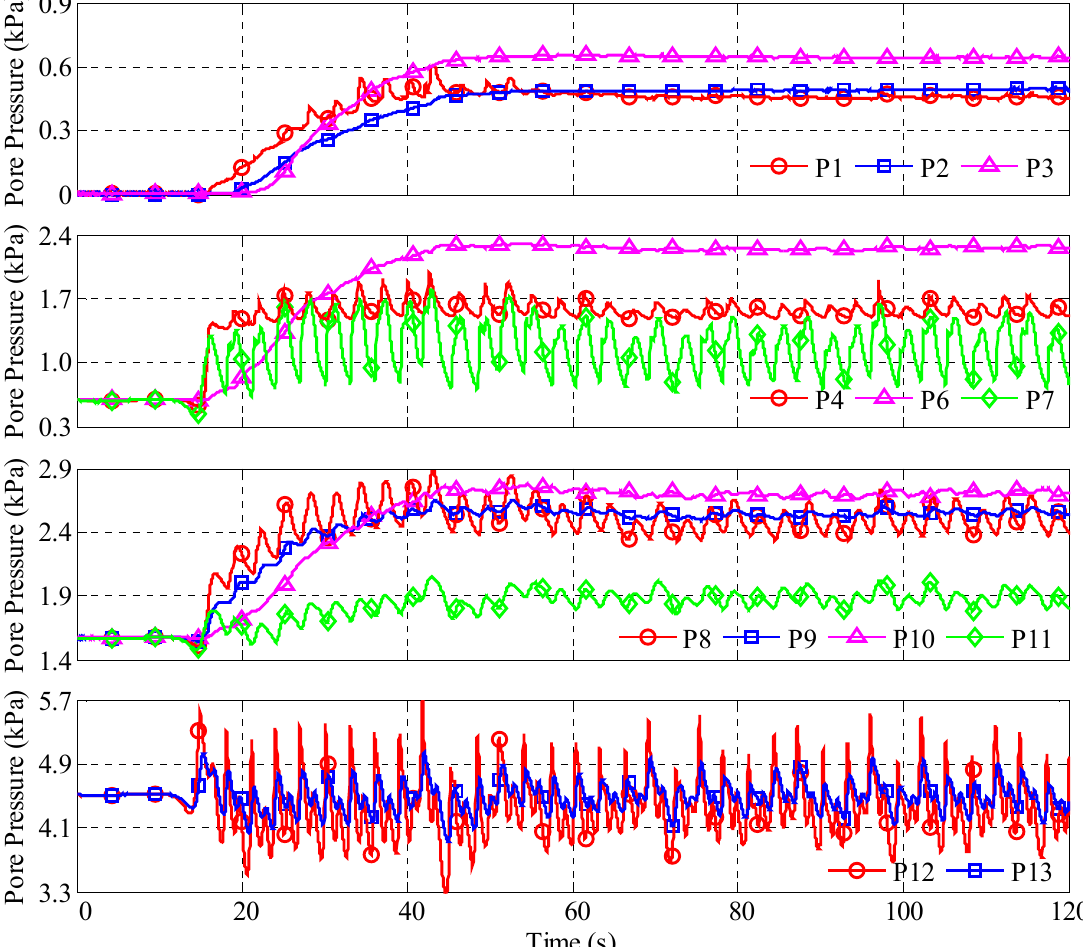
Figure 12. Time history of the wave-induced pore pressure in the reclaimed coral sand foundation in Test 3 (in the first 2 min).